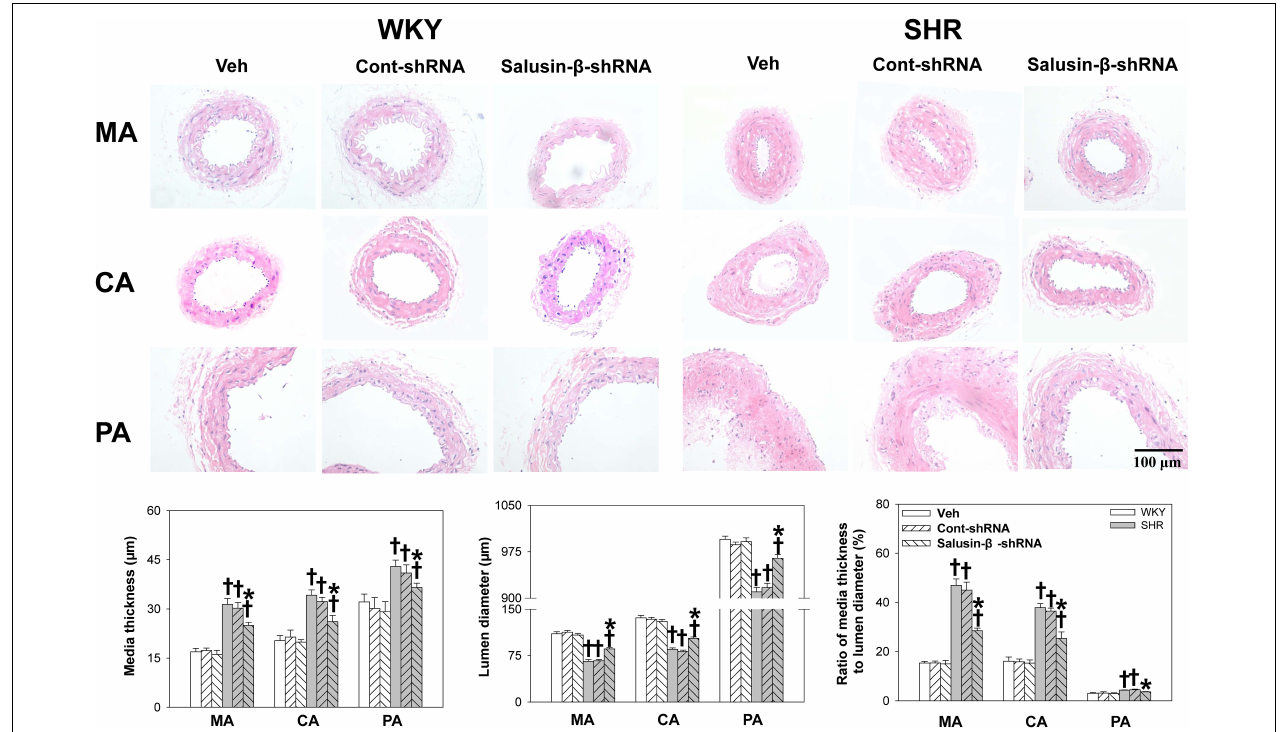
FIGURE 3 | The media thickness, lumen diameter, and media thickness/lumen diameter of MA, CA, and PA in WKY and SHR after salusin- β knockdown. Two-way ANOVA was used for data analysis, followed by Bonferrioni post hoc test to compare with the multiple groups. Values are mean ± SE. ∗ P < 0.05 compared with Veh or Cont-shRNA, † P < 0.05 compared with WKY. n = 6 for each